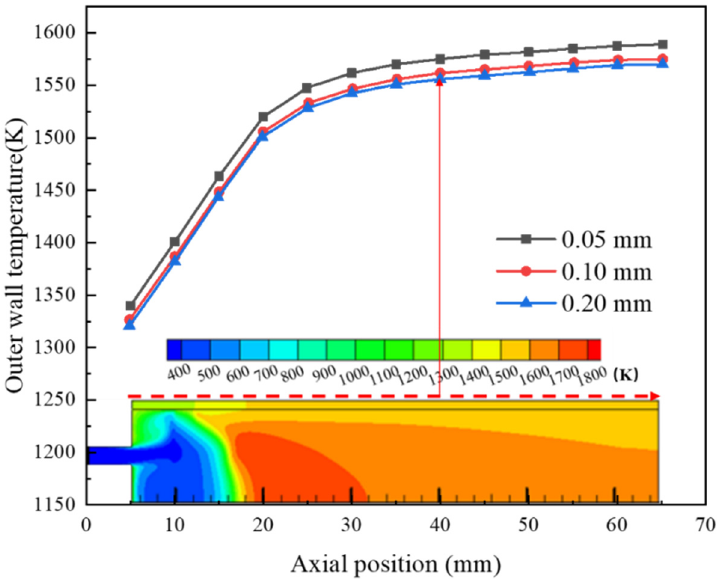
Figure 3. Mesh independence verification.